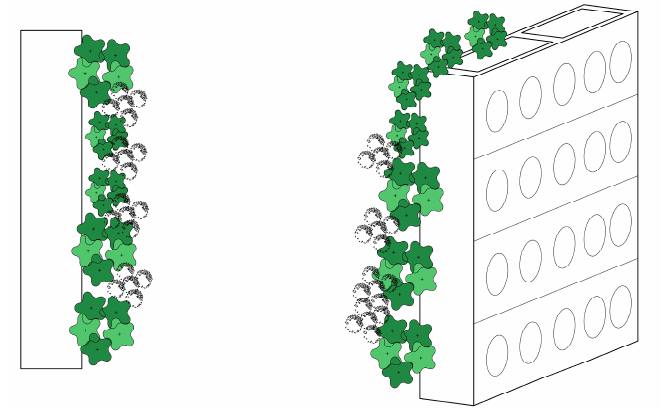
Figure 10. Biotile component overview based on